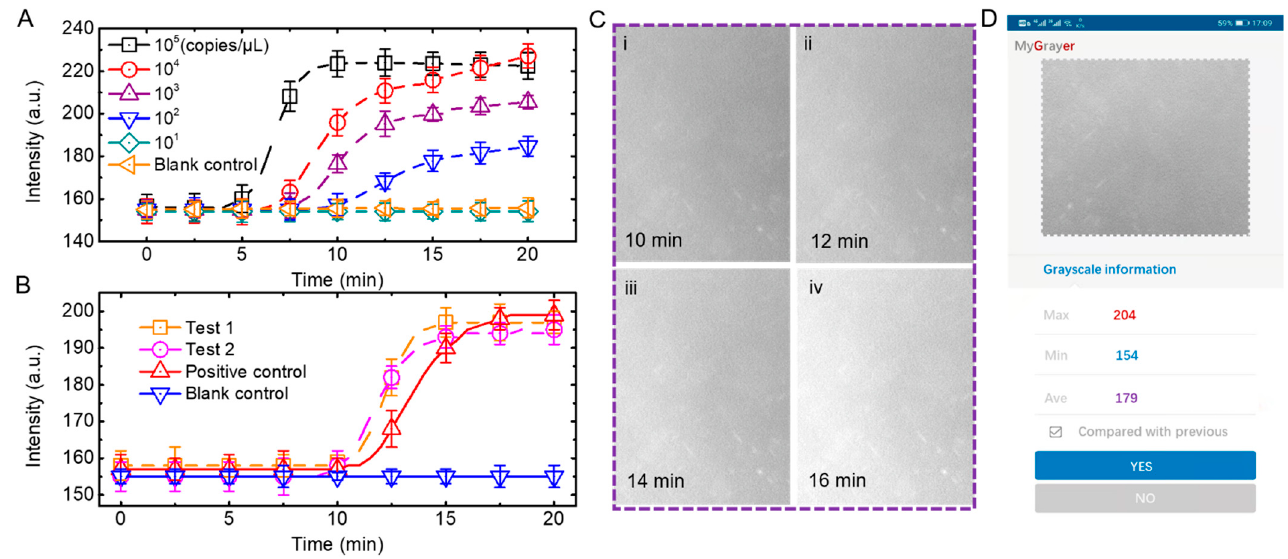
Figure 5. Application of duck products authenticating. ( A ) Results of real-time amplification of nucleic acids using concentrations of 10 5 copies/ µ L, 10 4 copies/ µ L, 10 3 copies/ µ L, 10 2 copies/ µ L, 10 1 copies/ µ L and blank control, respectively. ( B ) Fluorescence intensity as a function of time during nuclei acid amplifications. ( C ) Images of the green channel (emission) after separation were captured at 10 min, 12 min, 14 min, and 16 min. ( D ) Android application for grayscale analysis of fluorescence intensities.